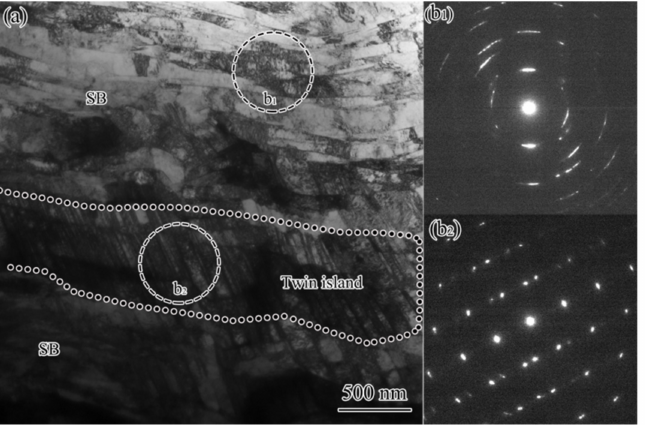
Figure 9. TEM observation ( a ) and the corresponding SAED patterns from SB ( b 1 ) and twin island ( b 2 ) in USRT AISI 304 stainless steel